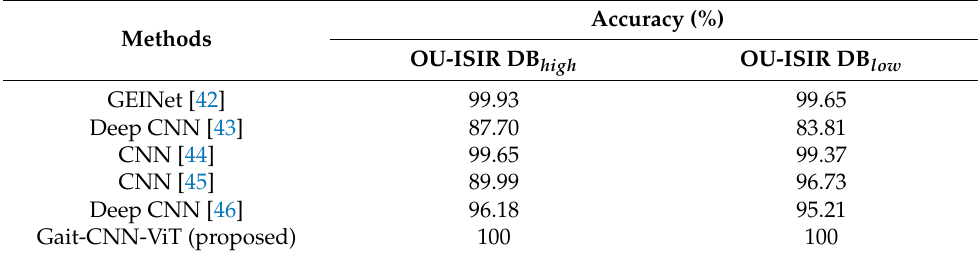
Table 4. Comparison results on the OU-ISIR dataset